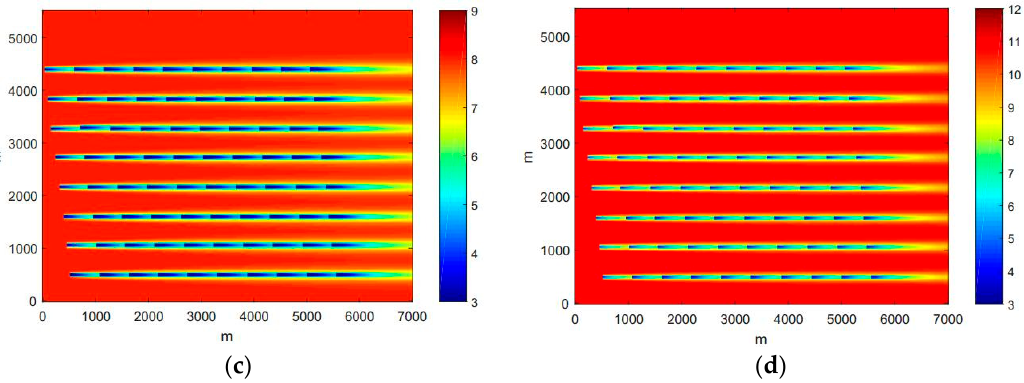
Figure 13. Wake velocity of Horns Rev wind farm in different wind direction and speed. (a) 210°, 8 m/s; (b) 210°, 11 m/s; (c) 270°, 8 m/s; (d) 270°, 11 m/s.